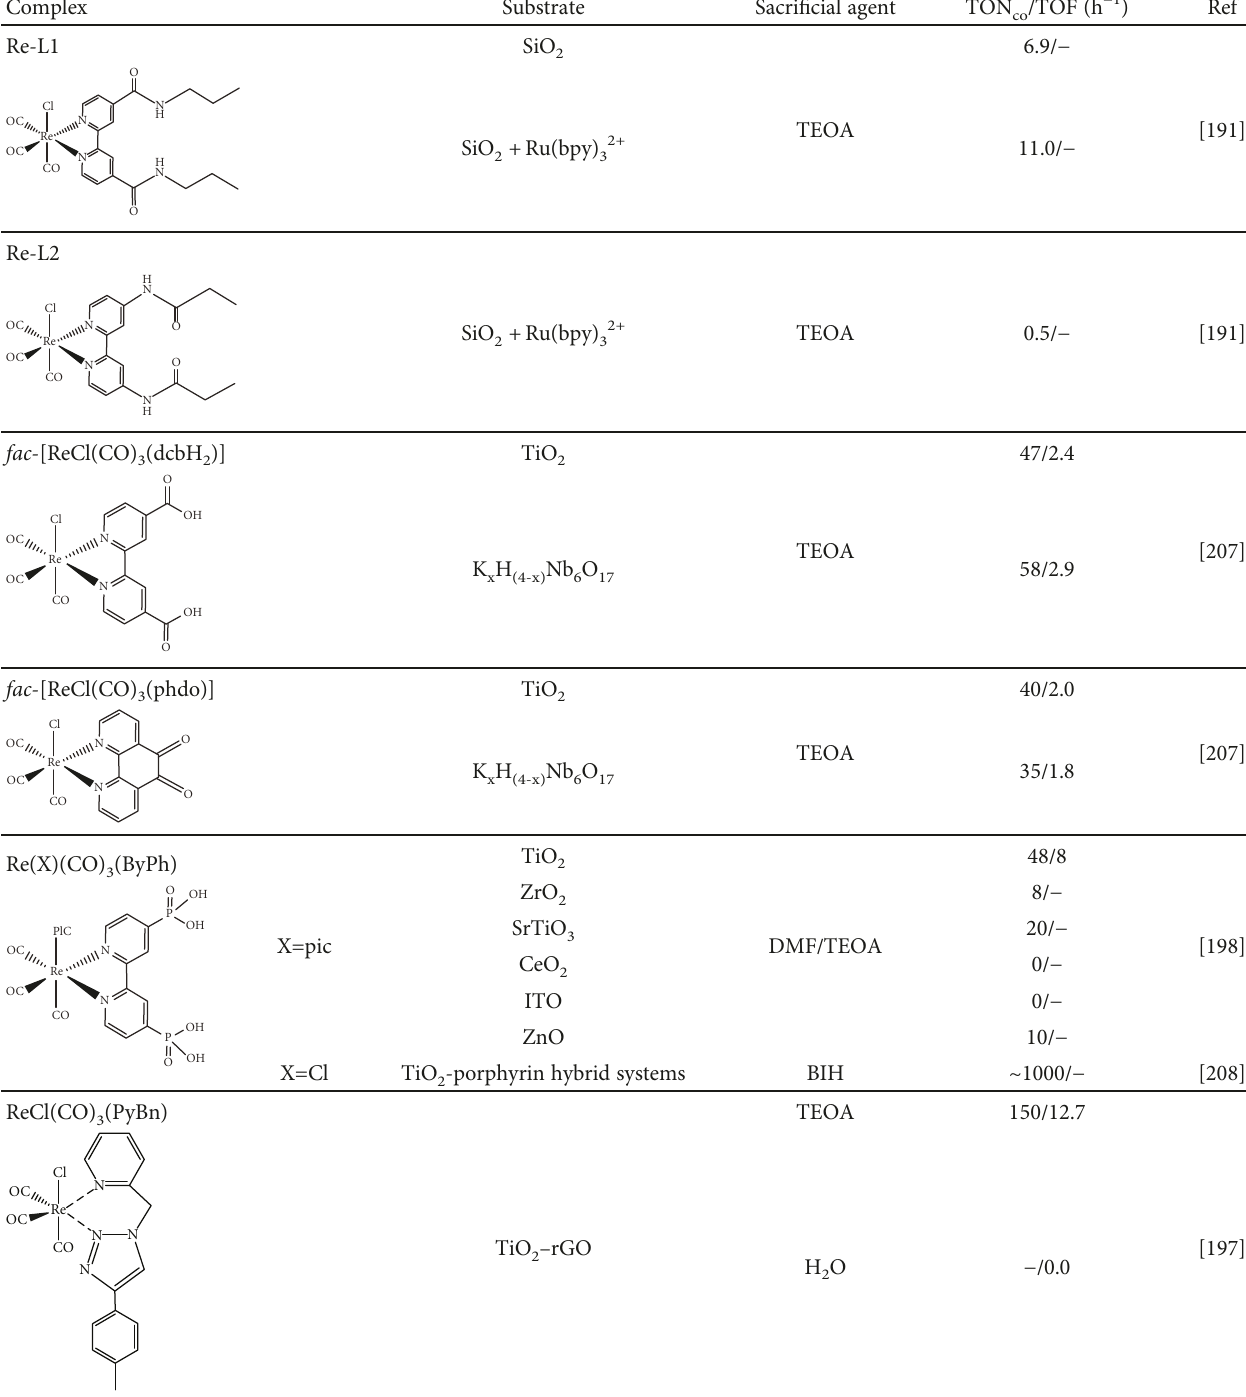
Table 2: Reported photoactivities of immobilized Re(I)